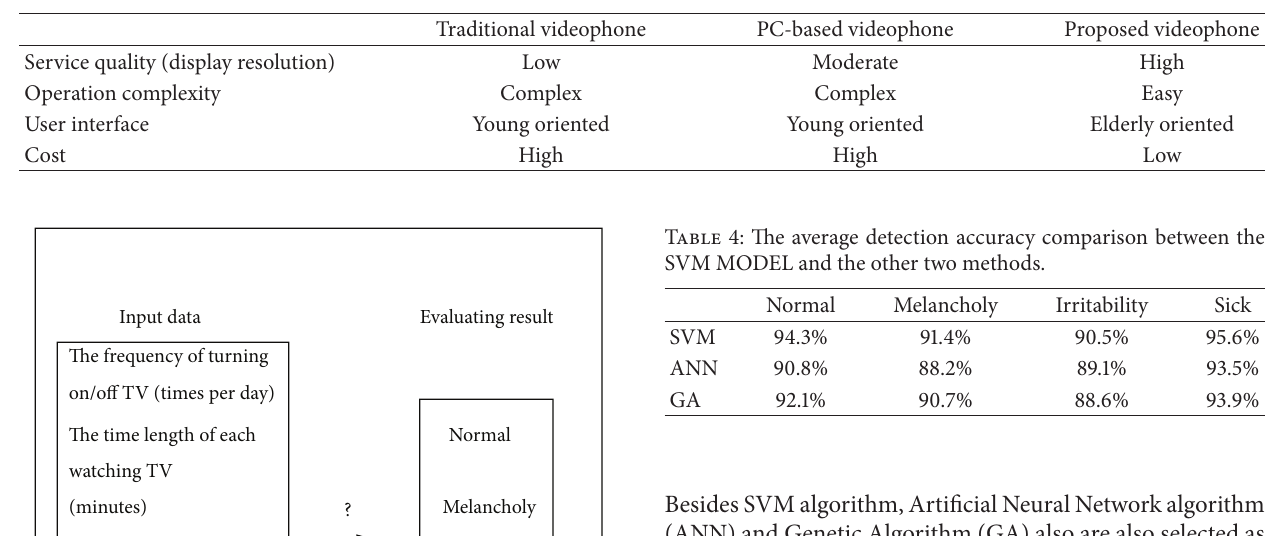
Table 3: Comparison between the proposed videophone and the other two videophones.